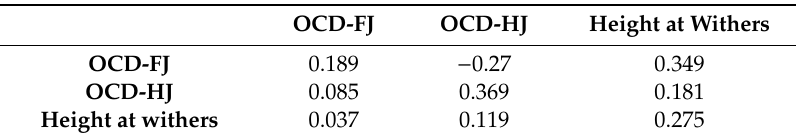
Table 2. Heritabilities (diagonal), genetic correlations (above diagonal) and residual correlations (below diagonal) of osteochondrosis dissecans in fetlock joints (OCD-FJ), osteochondrosis dissecans in hock joints (OCD-HJ) and of the height at withers [6].